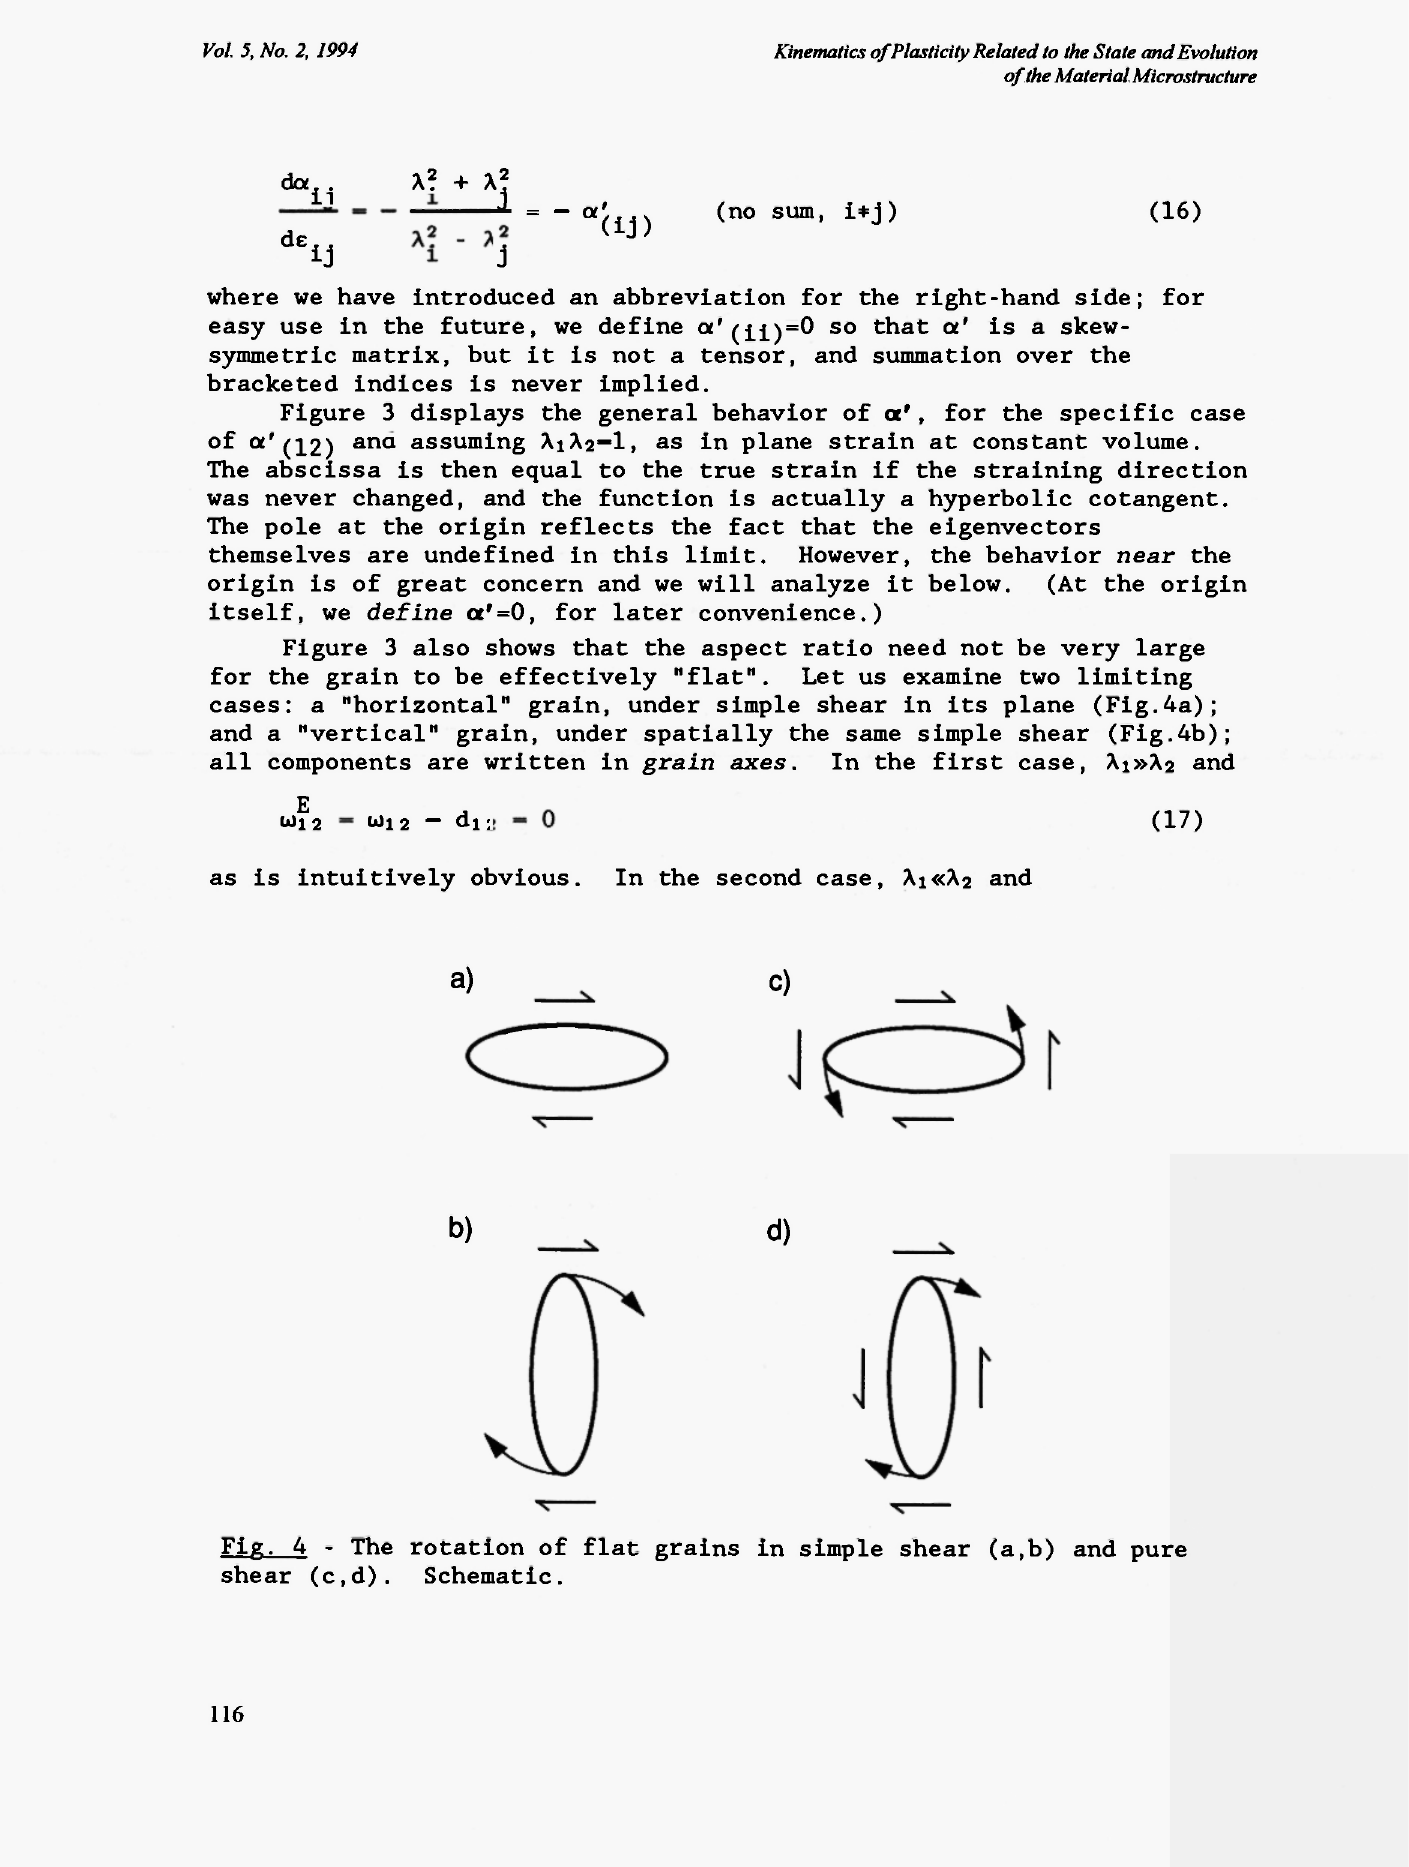
Fig. 4 - The rotation of flat grains in simple shear (a,b) and pure shear (c,d).